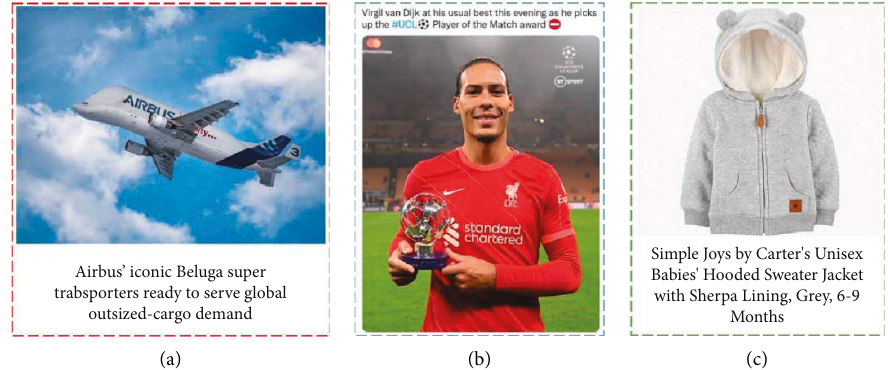
Figure 1: Image examples. (a) and (b) are randomly selected from Tumblr and Twitter, respectively. (c) is randomly picked from Amazon